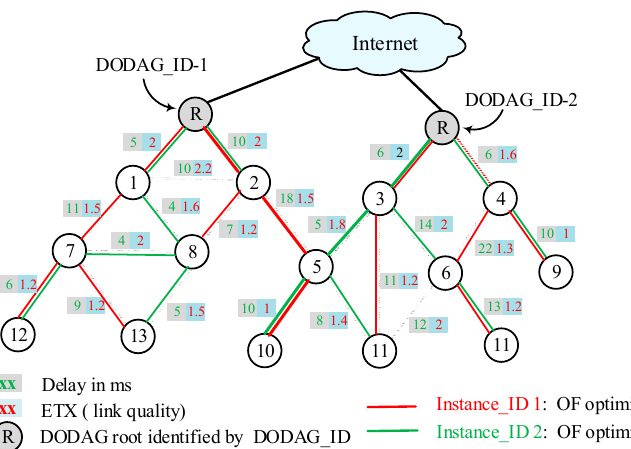
Figure 3. RPL DAG structure with multiple Instances and multiple DODAGs.